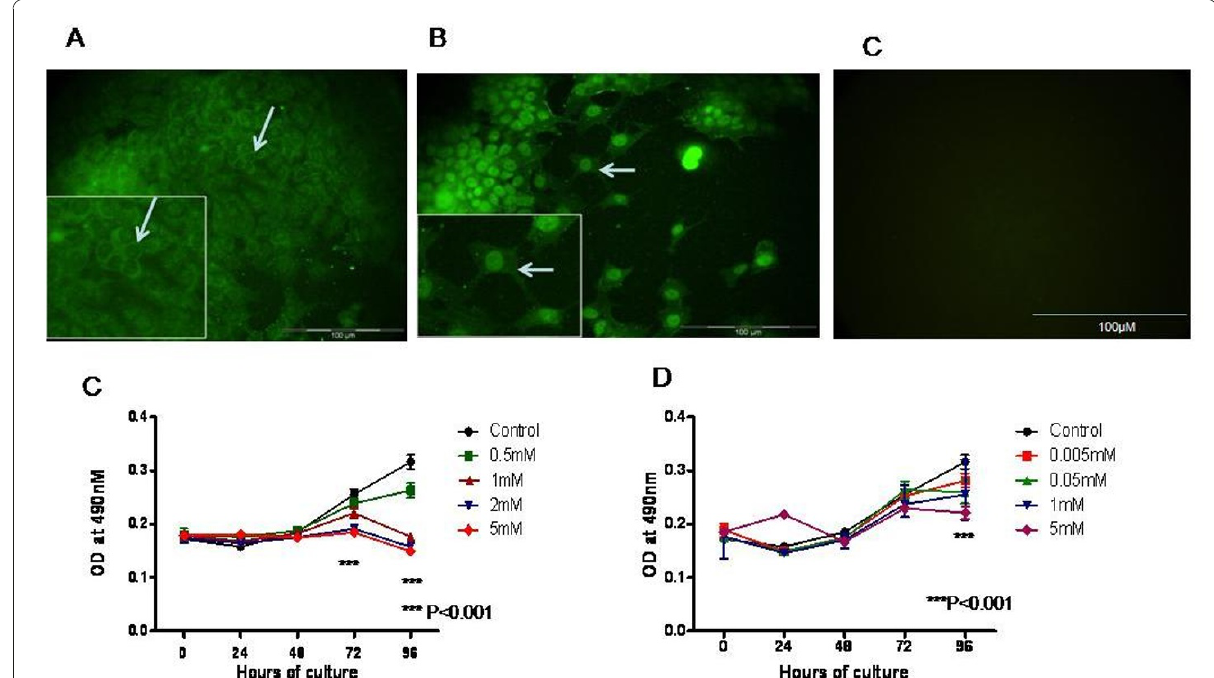
Figure 2 Immunocytochemistry of SK-OV-3 cells and effect of voltage gated K+ channel blockers 4-AP and TEA on their proliferation. Immunofluorescence staining of SK-OV-3 cells with (A) Eag and (B) HERG antibodies. Eag localises to the cell membrane and cytoplasm with little nuclear staining whereas HERG expression is mainly nuclear (higher magnification is shown in inset) (C) 4-AP significantly inhibited SK-OV-3 cell proliferation at 1,2 and 5 mM at 72 and 96 hrs while TEA (D) showed similar inhibition at 5 mM that was significant at 96 hours